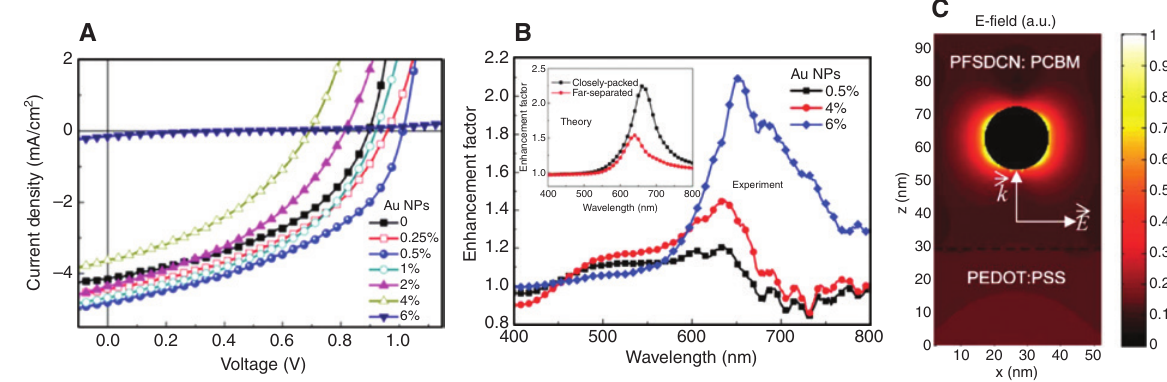
Figure 4: The plasmon-induced energy transfer in photovoltaic devices. (A) Current-voltage characteristics of the representative polymer solar cell containing different concentrations of 20 nm Au NPs. (B) Experimental and theoretical (inset) absorbance enhancement factors of the active polymer layer containing different concentrations of Au NPs. (C) Theoretical near-field distribution around an Au NP in the active layer. Adapted from Ref. [58] with permission from the Royal Society of Chemistry.